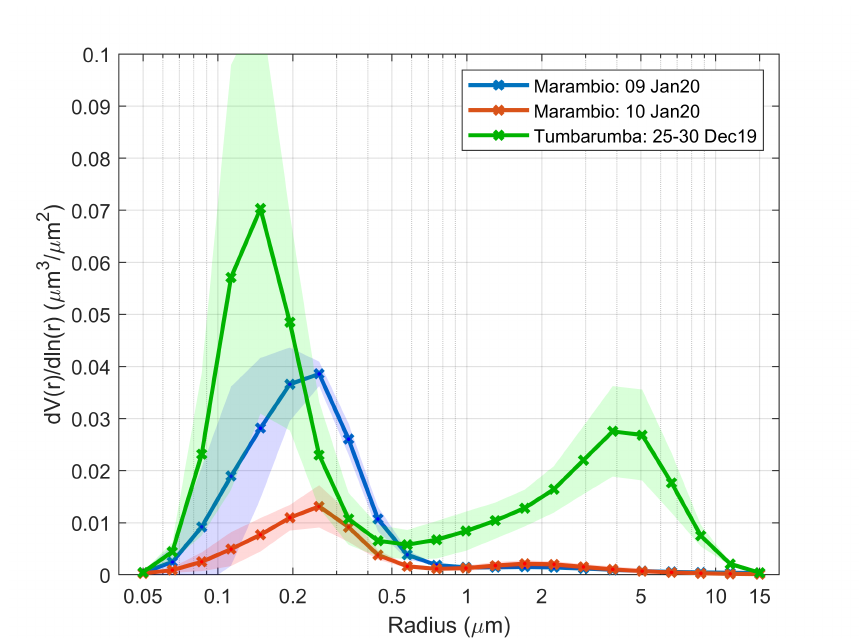
Figure 7. Volume particle size distribution over Marambio, Antarctica, on 9th and 10th January 2020 (daily averages), as well as the mean of the daily averaged size distribution over Tumbarumba, Australia, for the period 25–30 December 2019. Color shaded areas represent ± 1 standard